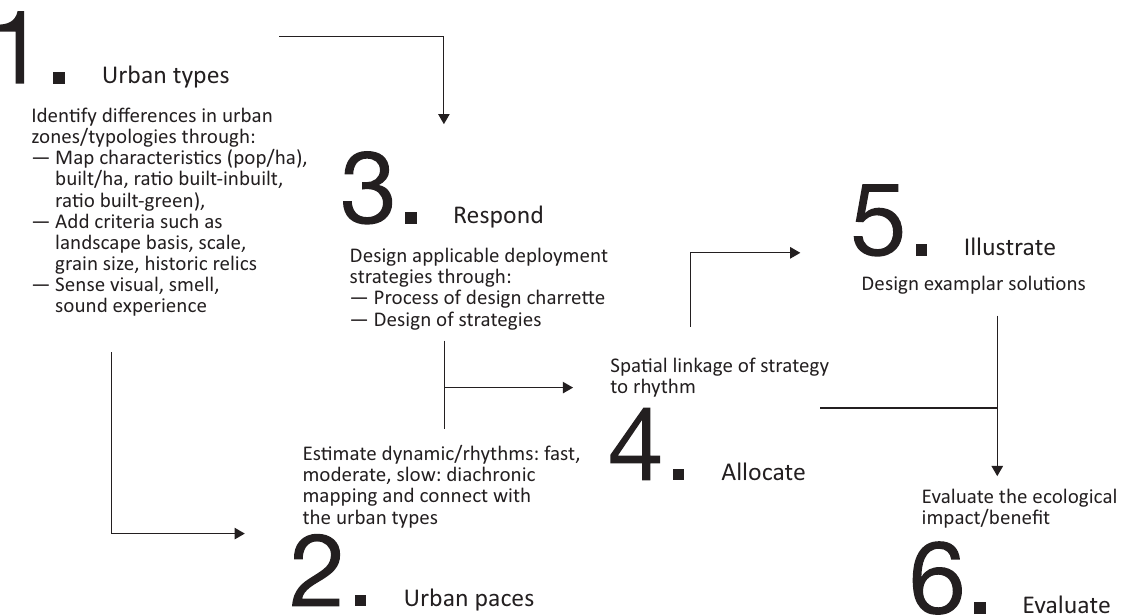
Figure 3. Methodology used for constructing a rapid deployment strategy for